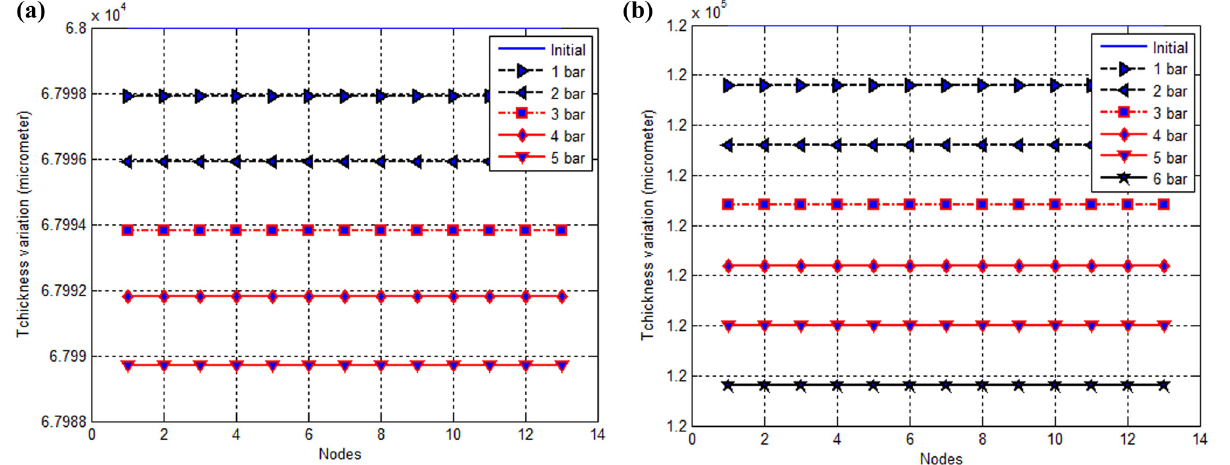
Figure 9: ( a ) Thickness evolution in the thin ring. ( b ) Thickness evolution in the thick